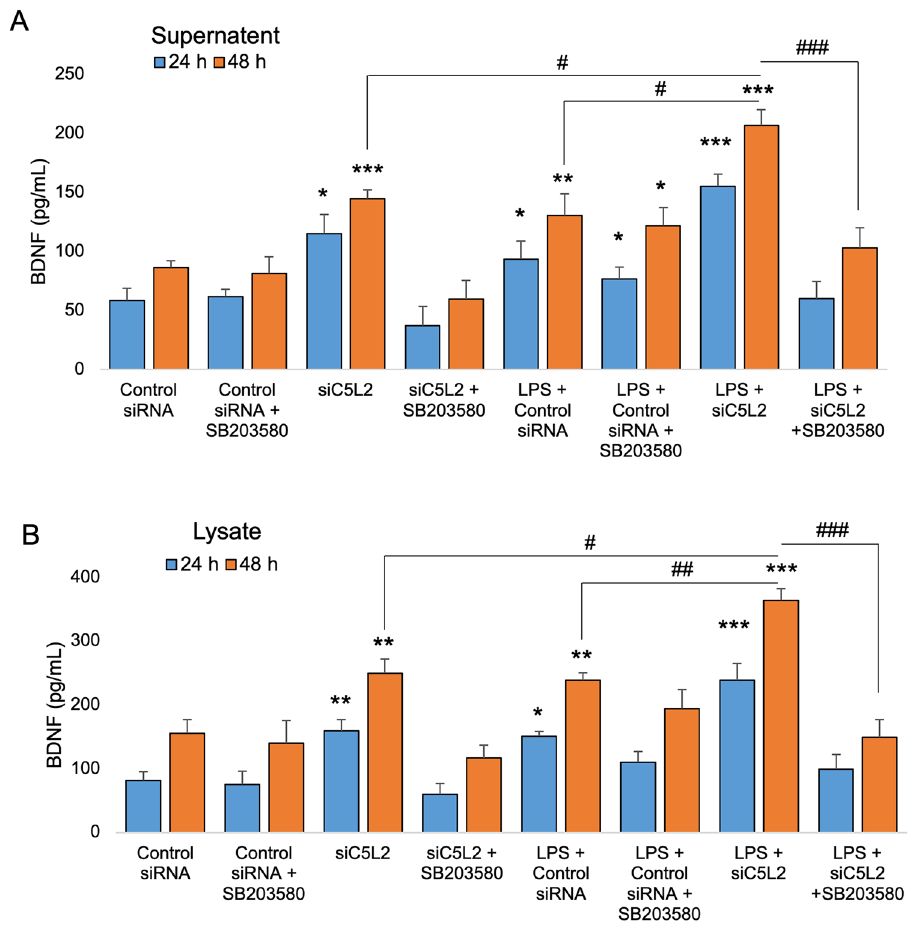
Figure 5. Effects of C5L2 mediated BDNF secretion in DPSCs in supernatant and cell lysates. ( A-B ) Cells were cultured and incubated with various treatments such as control siRNA, C5L2 siRNA, and/or SB203580 with or without LPS. Supernatant (conditioned media) or cell lysates were collected at 24 h and 48 h of treatments, and an ELISA was performed to quantify BDNF secretion in C5L2 mediated DPSCs according to the manufacturer’s protocol. ( A ) In supernatant, BDNF production was significantly increased in C5L2 silenced cells with or without LPS at both 24 h and 48 h. However, SB203580 treatment reversed the BDNF production. ( B ) Similar trend was observed in cell lysates with significant higher BDNF secretion as compared to cell supernatant (* p < 0.05, ** p < 0.01, and *** p < 0.001 vs control; # p < 0.05, ## p < 0.01, and ### p < 0.001 vs respective line- indicated